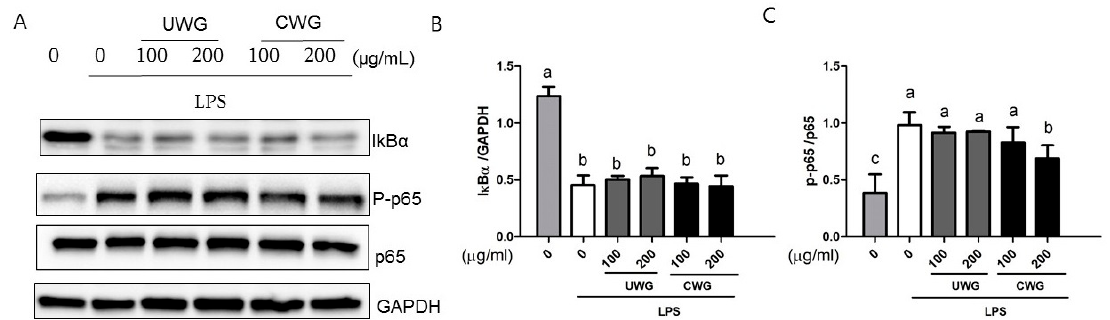
Figure 5. Effect of CWG on LPS-induced I κ B α degradation and phosphorylation of NF- κ B p65. Mouse peritoneal macrophages were pretreated with UWG or CWG for 1 h and then stimulated with LPS for 15 min. ( A ) The expression level of I κ B α and phosphorylated p65 was determined by Western blotting. GAPDH was used as an internal control. One of three experiments is shown; ( B , C ) Bars represent the intensity of normalized target protein band ( n = 3). Different letters indicate statistical significances ( p < 0.05).